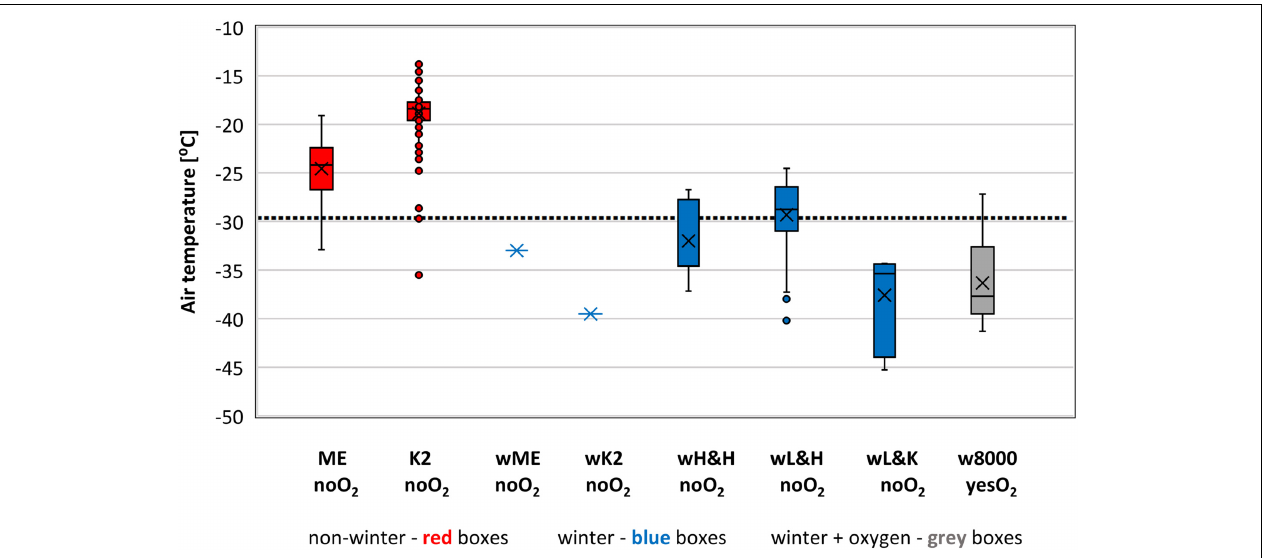
FIGURE 2 | Air temperature experienced on the summits we analyzed. Sample size – 499 ascents without supplemental oxygen and 29 with supplemental oxygen (1978–2021). Bars extend to the maximum and minimum BP, boxes span the 25th–75th percentiles, crosses inside the boxes mark mean values, horizontal lines inside the boxes represents median values, dots mark outliers, dotted line represents 10th percentile value of – 30 ◦ C for all 499 ascents without supplemental oxygen.